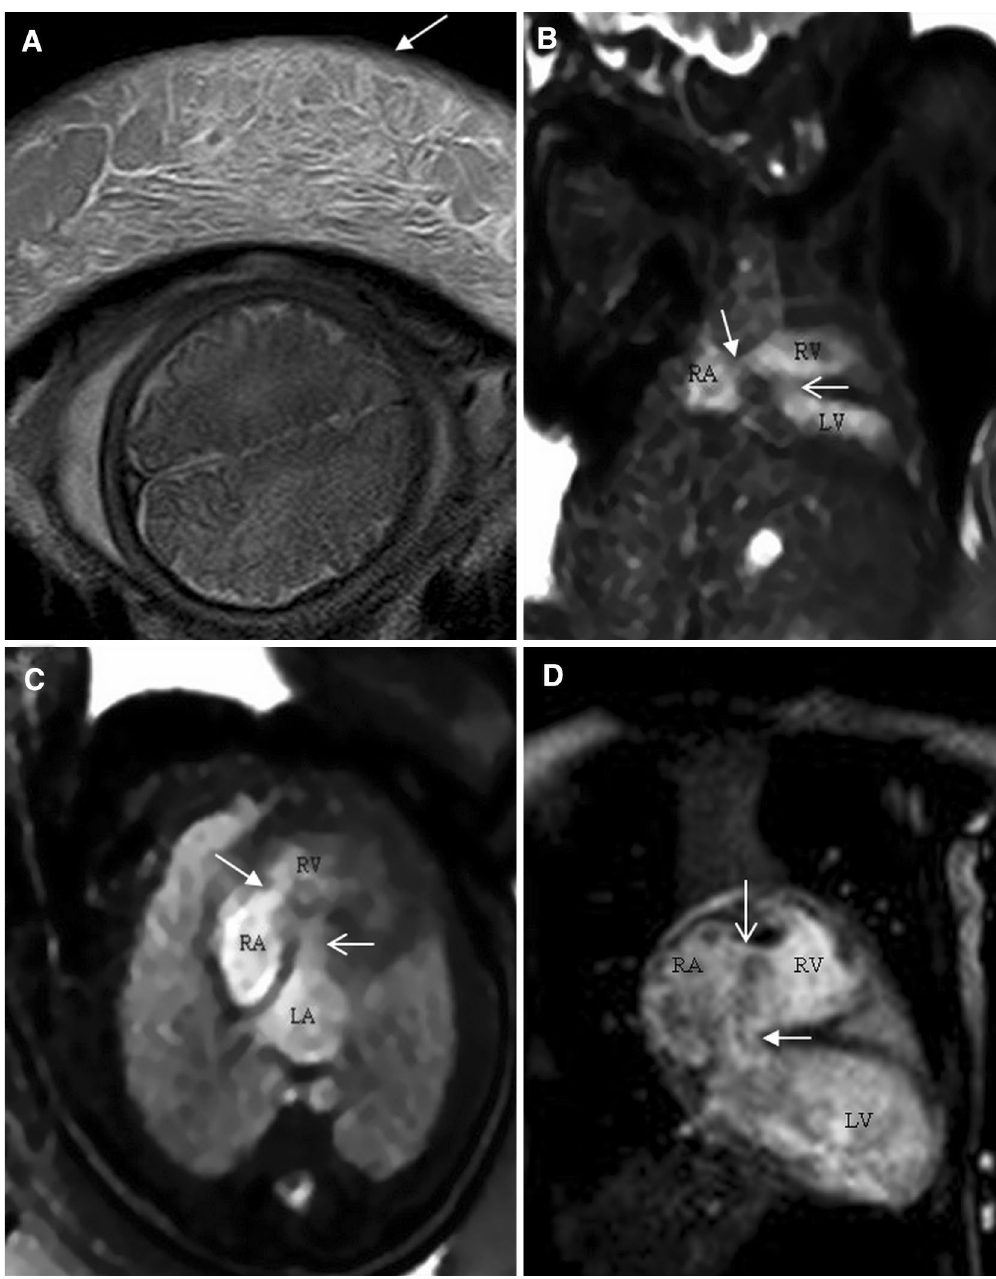
Figure 5. A 34-week-old foetus with a criss-cross heart. A 34-week-old foetus had a echocardiography at 22 weeks of gestation that suggested the presence of transposition of the great arteries (D-TGA) and ventricular septal defect (VSD). Follow up foetal echocardiography at 34 weeks of gestation was limited because of increasing maternal subcutaneous oedema and obesity. An axial SSTSE image of the maternal abdomen demonstrating oedema of the subcutaneous soft tissues ( A , arrow). SSFP coronal and axial view images showing the right ventricle located superiorly ( B , RV), the horizontal ventricular septum with a VSD ( B , open arrow), the right atrium ( B , C RA) connected to the right ventricle ( B , C RV) in a right-to-left direction ( B , C arrow), and the left atrium (LA) connected to the left ventricle (LV) in a posteroanterior direction ( C , open arrow). A postnatal enhanced cardiac MR image showing a criss-cross heart (same as the prenatal cardiac MRI). The right ventricle was located superiorly ( D , RV), the horizontal ventricular septum with a VSD ( D , arrow), the right atrium ( D , RA) was connected to the right ventricle ( D , RV) in a right-to-left direction ( D , open arrow). The left atrium (LA) was connected to the left ventricle (LV) in a posteroanterior